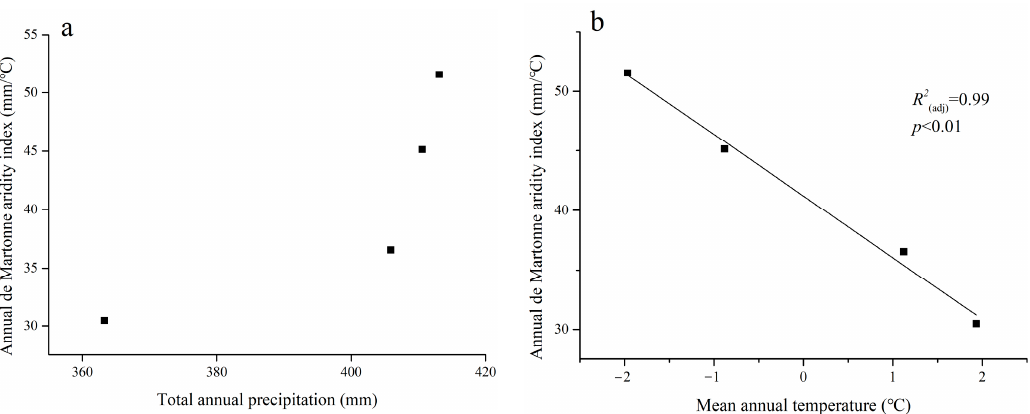
Figure 3. The relationships between the annual de Martonne aridity index and total annual precipitation ( a ) and mean annual temperature ( b ) for the sites in the middle of the Qilian Mountains.